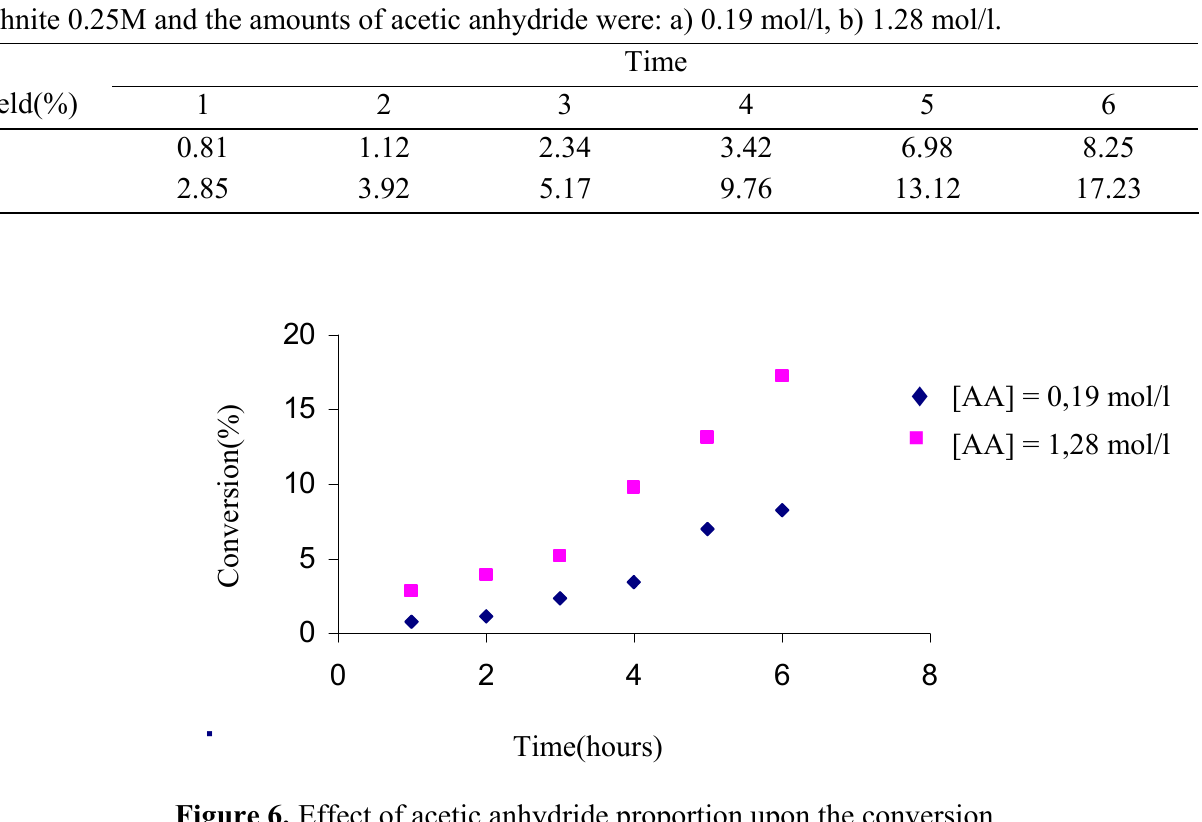
Figure 6. Effect of acetic anhydride proportion upon the